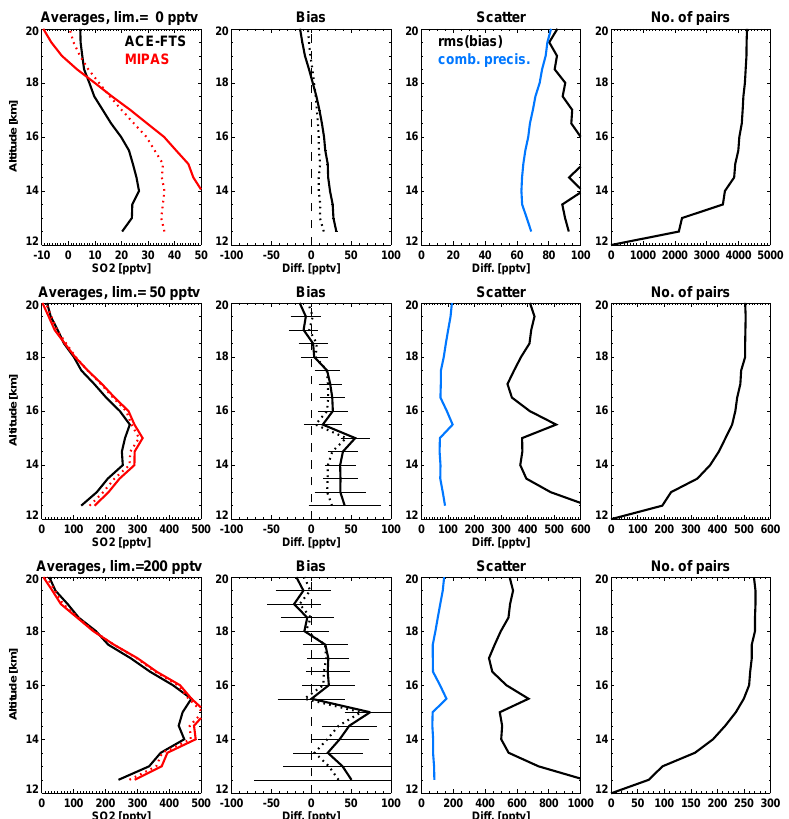
Figure 2. Comparison of MIPAS and ACE-FTS collocated single profile measurements. Left column: average profiles (red solid: MIPAS original data set, red dotted: MIPAS data set after debiasing; cf. Sect. 2.5). Second column: mean differences MIPAS-ACE-FTS (solid: before, dotted: after debiasing) together with their standard error (error bars; not visible in the top row since these are smaller than the line thickness) calculated as their SD (see third column) divided by the square root of the number of pairs (see last column). Third column: SD of the single differences (black line) and the mean value of the combined estimated precision of the two instruments (blue line). Fourth column: number of collocated pairs used for comparison at each altitude. Top row: only those pairs are selected where ACE-FTS profile values are smaller than 50 pptv up to 20 km altitude. Middle row: only those pairs are selected where ACE-FTS profile values are above 50 pptv at least at one altitude level up to 20 km. Bottom row: same as middle row but for a lower limit of 200